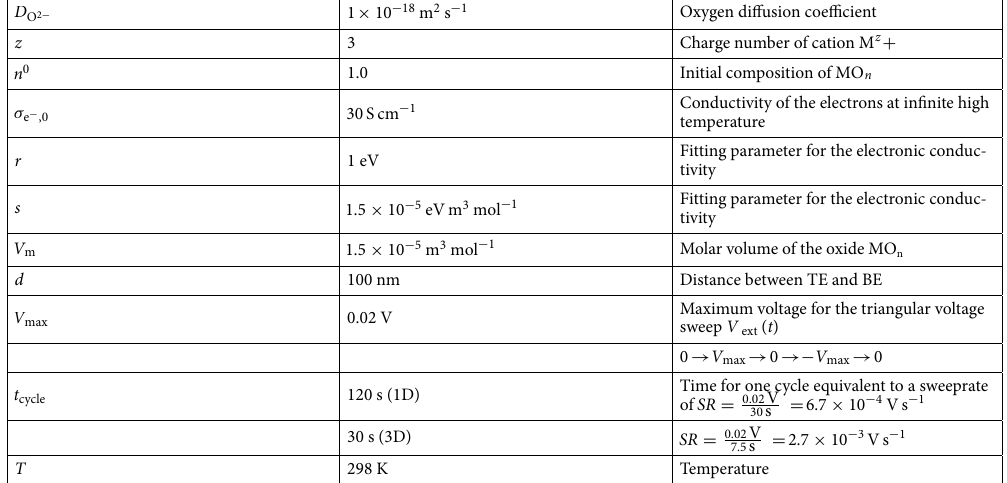
Table 1. Basic parameters for the simulation.